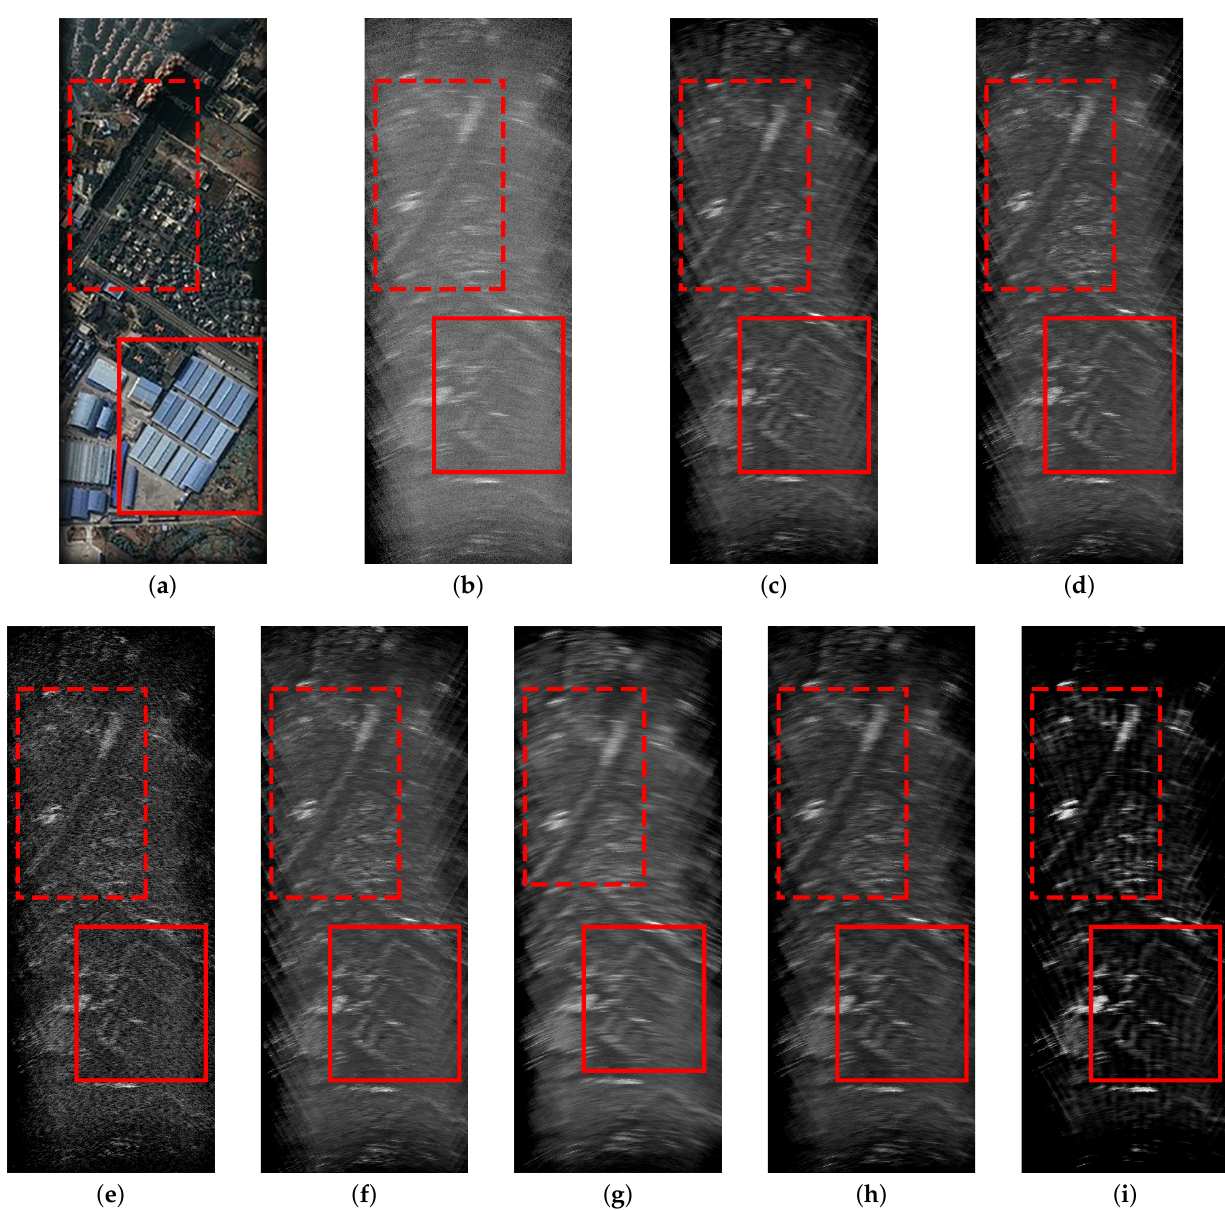
Figure 7. Super-resolution results of real data. ( a ) Optical scenario. ( b ) Real-aperture echo. ( c ) Result processed by TSVDM. ( d ) Result processed by FTVM. ( e ) Result processed by MLE. ( f ) Result processed by IAA. ( g ) Result processed by MAPE. ( h ) Result processed by SSM. ( i ) Result processed by